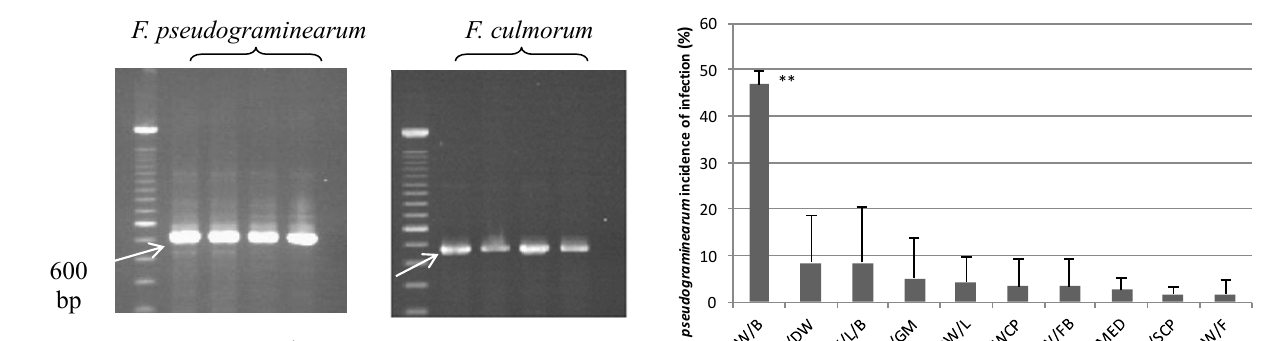
Figure 1. Agarose gel showing PCR products amplified with Fusarium pseudograminearum (Fp1-1, Fp1-2) and F. cul- morum (OPT18R, OPT18F) specific primers: 600-bp ladder as the DNA size marker. Table 2. Analysis of variance of the incidence of infection by Fusarium culmorum (Fc) and F. pseudograminearum (Fpg) on roots and stem bases of durum wheat for 10 previous rotation crops during 2007/08, 2008/09 and 2009/10 crop- ping seasons.